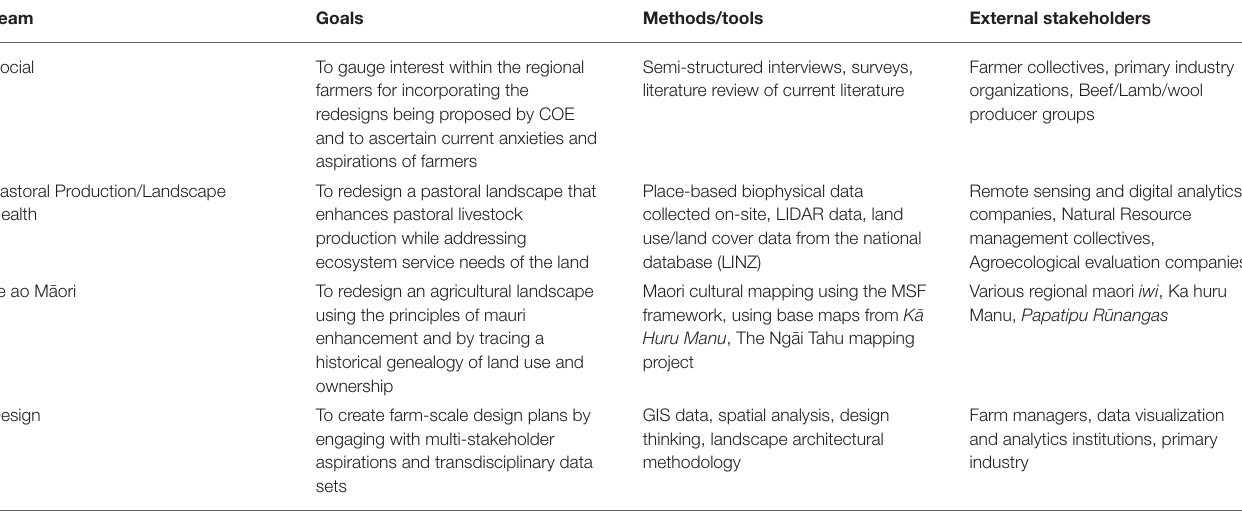
TABLE 1 | Breakdown of the different goals, methods, and stakeholders of the teams within the COE.